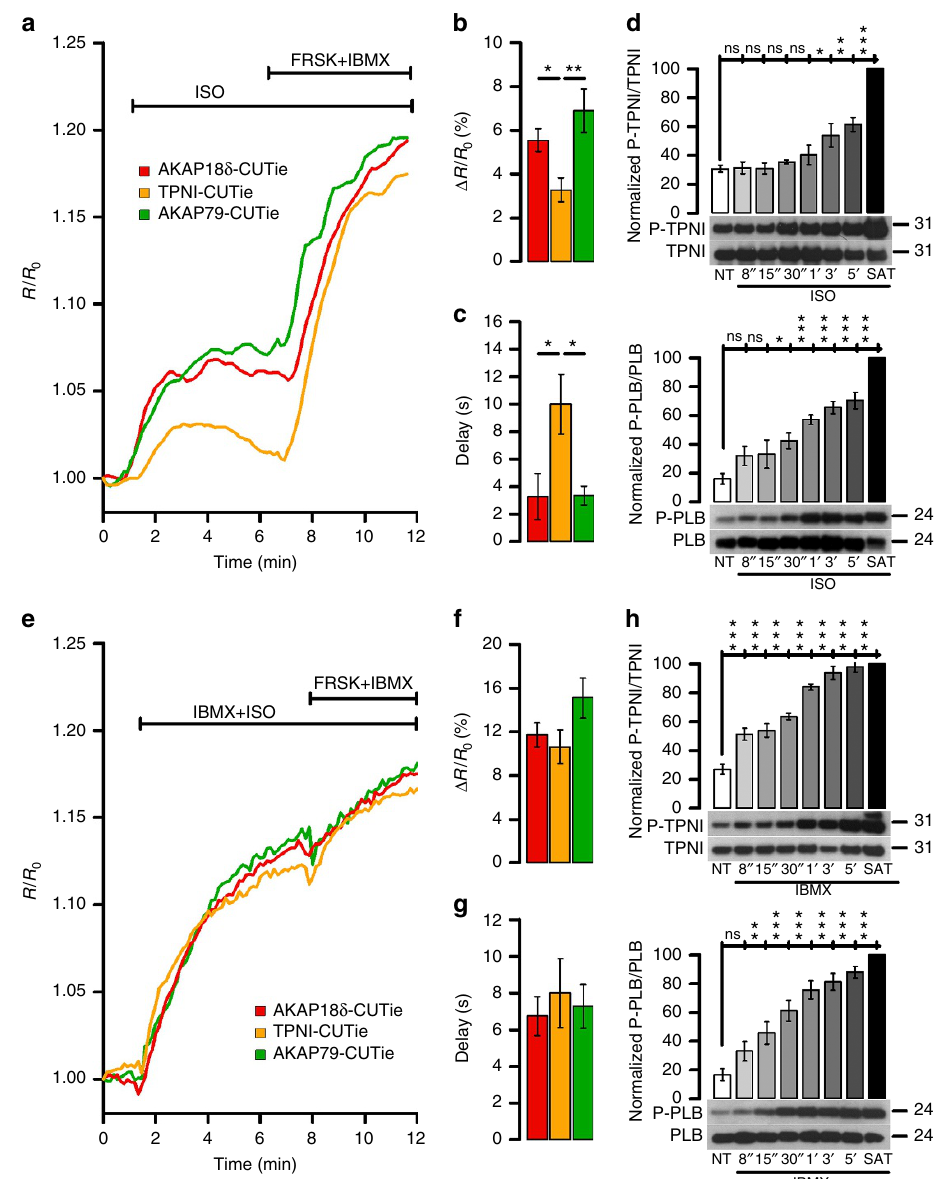
Figure 3 | Differential regulation of the cAMP signal at different b -adrenergic targets. ( a ) Representative kinetics and summary ( b ) of FRET change recorded in ARVM individually expressing AKAP18 d -CUTie, TPNI-CUTie or AKAP79-CUTie in response to bath application of 5nM ISO. One-way ANOVA with Bonferroni’s post-hoc correction. ( c ) Delay from application of 5nM ISO to first time point at which a FRETchange was detected for all experiments performed as in a . One-way ANOVA with Bonferroni’s post hoc correction. ( d ) Time course of TPNI (top) and PLB (bottom) phosphorylation on application of 1nM ISO to NRVMs. The level of phosphorylation on application of a saturating stimulus (SAT: 25 m M FRSK þ 100 m M IBMX) for 10min is also shown. NT, no treatment. N ¼ 5 biological replicates. One-way ANOVA with Dunnett’s post hoc correction (all columns versus NT column). ( e ) Representative kinetics and summary ( f ) of FRETchange recorded in ARVM individually expressing AKAP18 d -CUTie, TPNI-CUTie or AKAP79-CUTie in response to bath application of 1nM ISO in combination with 100 m M IBMX. One-way ANOVA with Bonferroni’s post hoc correction. ( g ) Delay from application of 1nM ISO þ 100 m M IBMX to first time point at which a FRETchange was detected for all experiments performed as in e . ( h ) Time course of TPNI (top) and PLB (bottom) phosphorylation on application of 100 m M IBMX to NRVM. N ¼ 5 biological replicates. One-way ANOVA with Dunnett’s post hoc correction (all columns versus NTcolumn). Bars indicate means ± s.e.m. For ( b , c , f , g ) N Z 7 from at least N ¼ 5 biological replicates. * P r 0.05, ** P r 0.01, *** P r